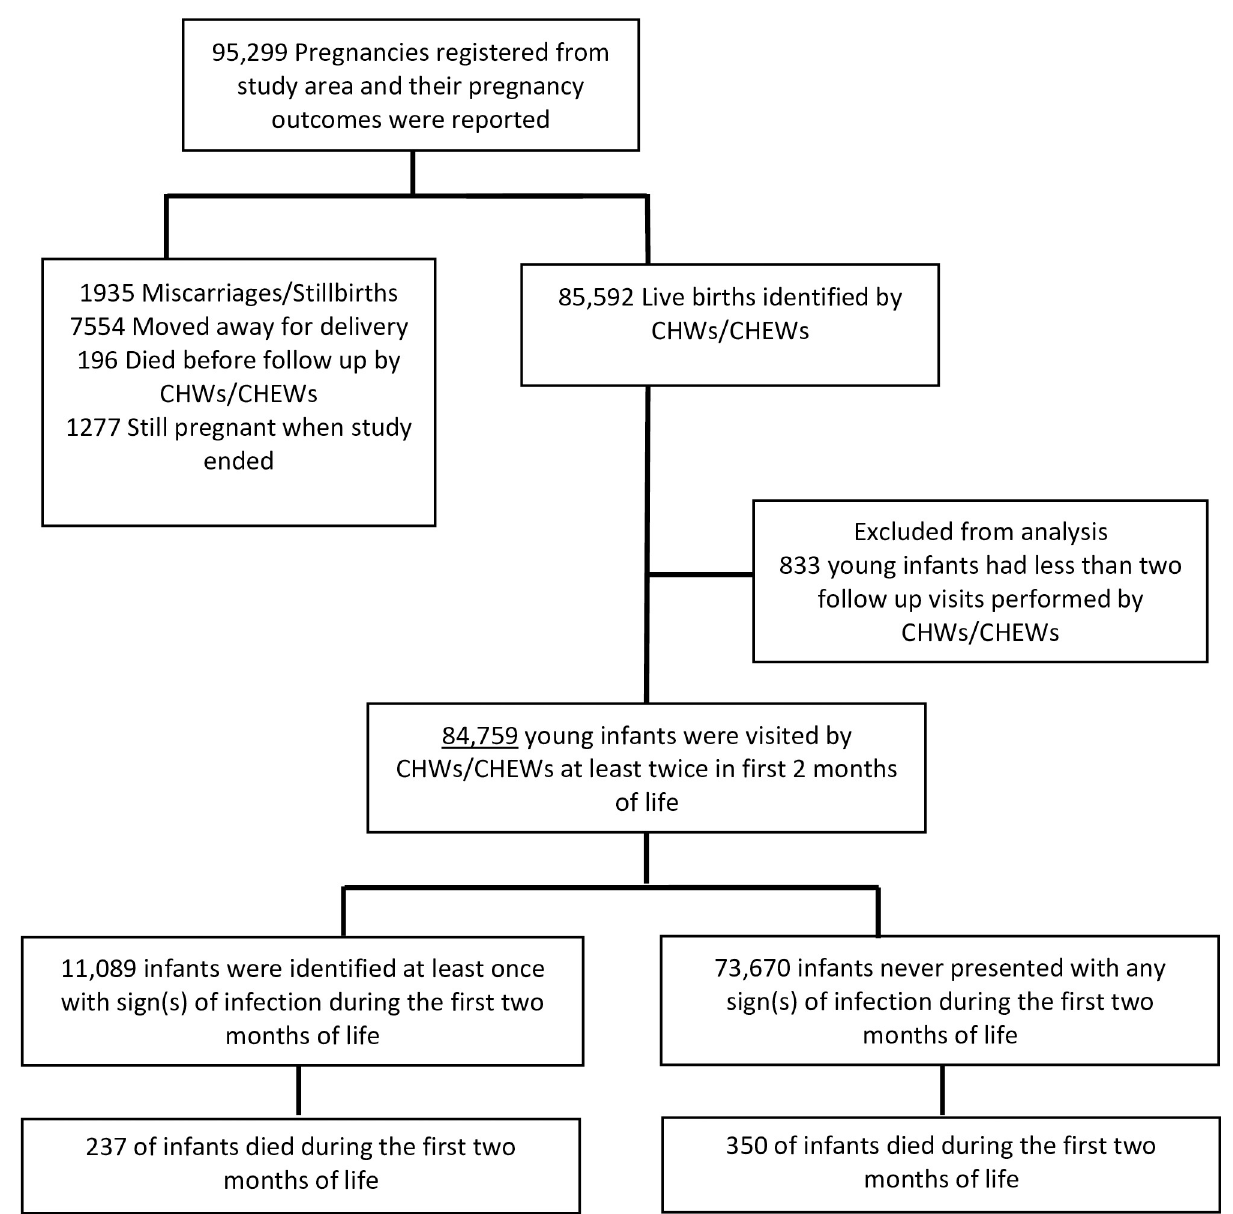
Fig 1. Flow diagram of the exclusion criteria to establish the study population. CHW: Community health worker. CHEW: Community health extension worker.